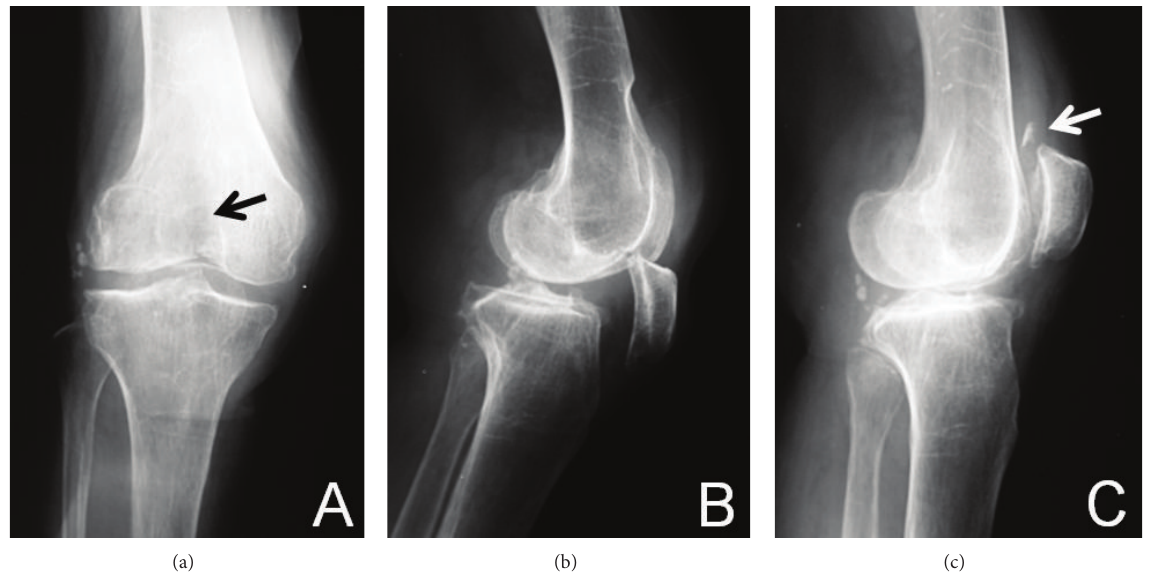
Figure1:(a)Plainfrontalradiography:anintra-articularfracture(arrow)isevidentfromthecondylarfossatothelateralcondyleofthefemur. (b) Plain lateral radiography: the patella is dislocated inferiorly. (c) Plain radiography after manual reduction: the remaining osteophyte and a floating bone fragment are visible (arrow).